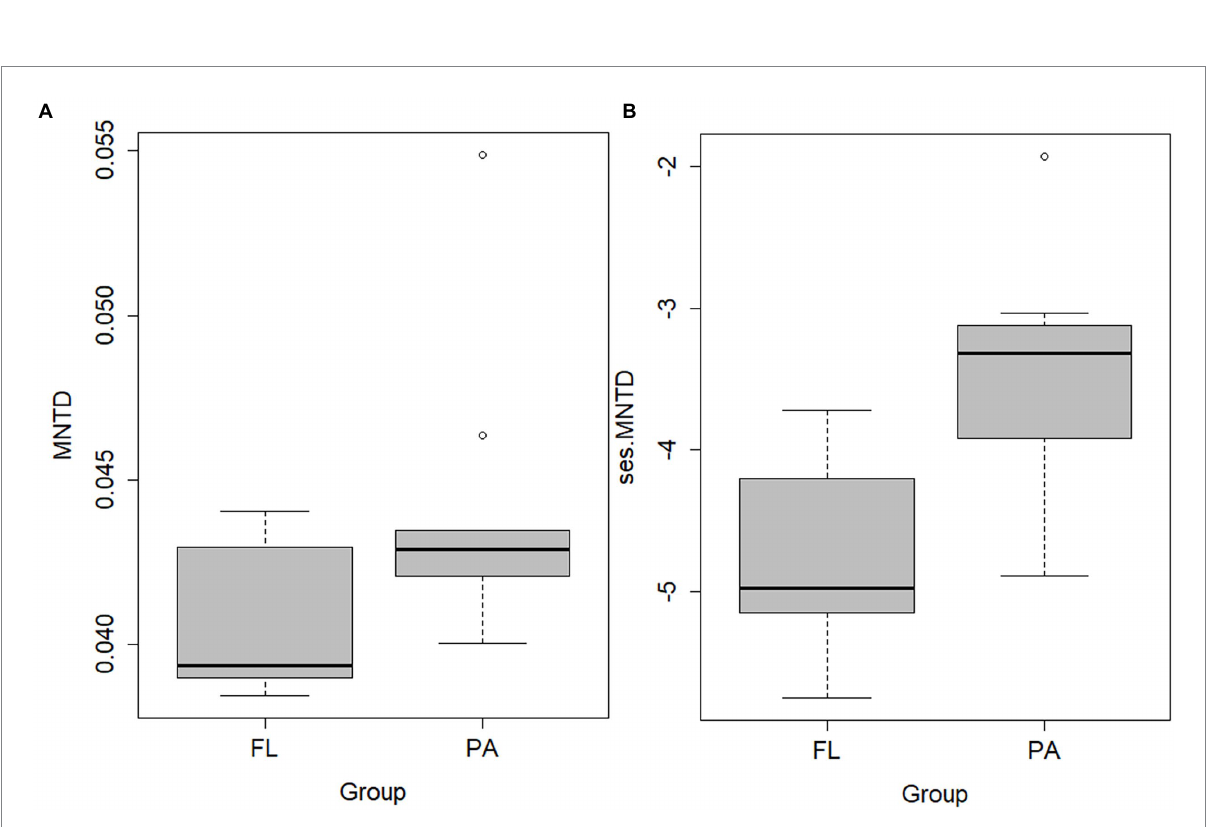
FIGURE 5 MNTD (A) and the standardized -effect size of MNTD (ses.MNTD); (B) of the FL and PA bacterial